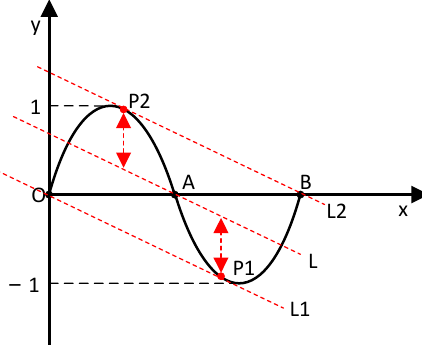
Figure 2. The graph of the sine function.